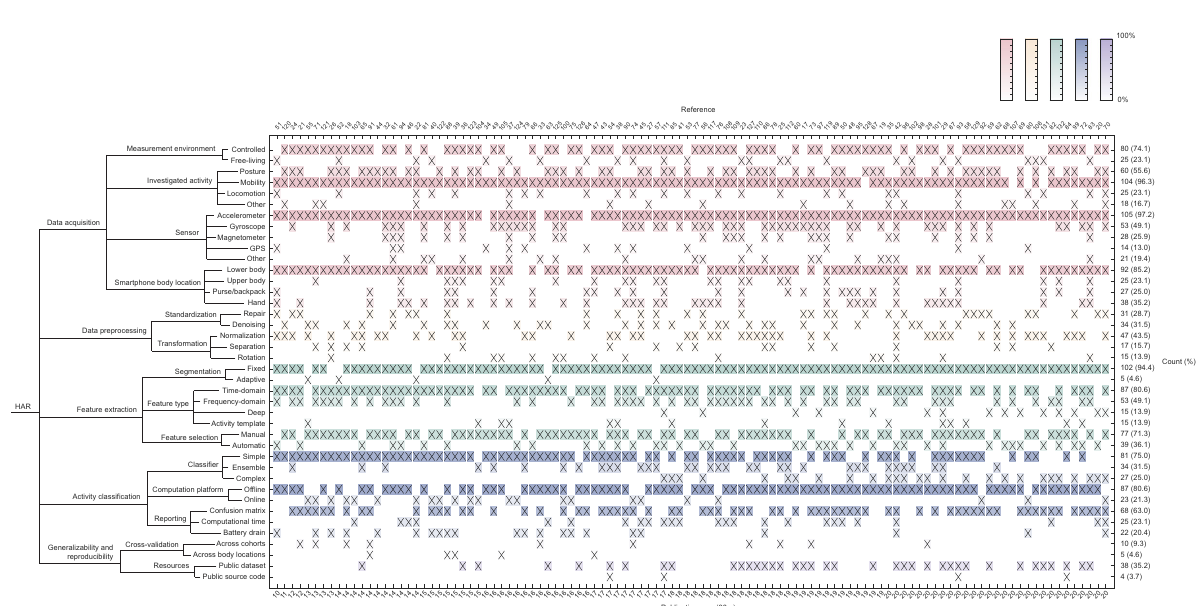
Fig. 4 Summary of HAR systems using smartphones. The columns correspond to the 108 reviewed studies and the rows correspond to different technical aspects of each study. Cells marked with a cross (x) indicate that the given study used the given method, algorithm, or approach. Rows have been grouped to correspond to different stages of HAR, such as data processing, and color shading of rows indicates how frequently a particular aspect is present among the studies (darker shade corresponds to higher